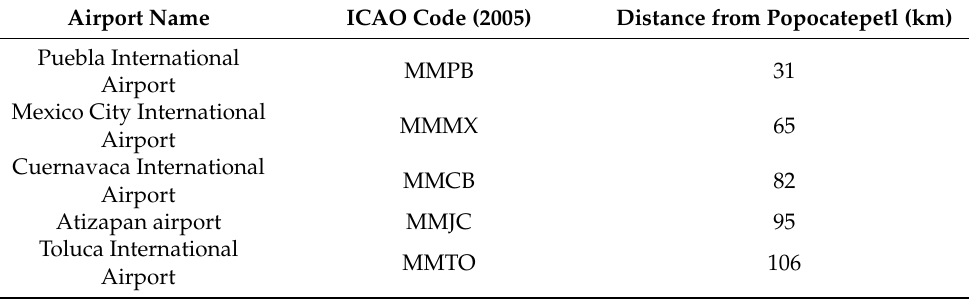
Table 1. Airports around the Popocatepetl volcano within a radius of 110